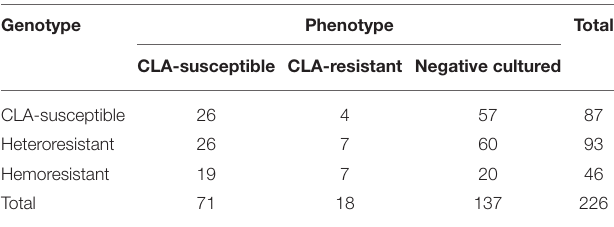
TABLE 4 | The eradication rate, adverse reaction, and compliance of phenotype- and genotype-guided therapy